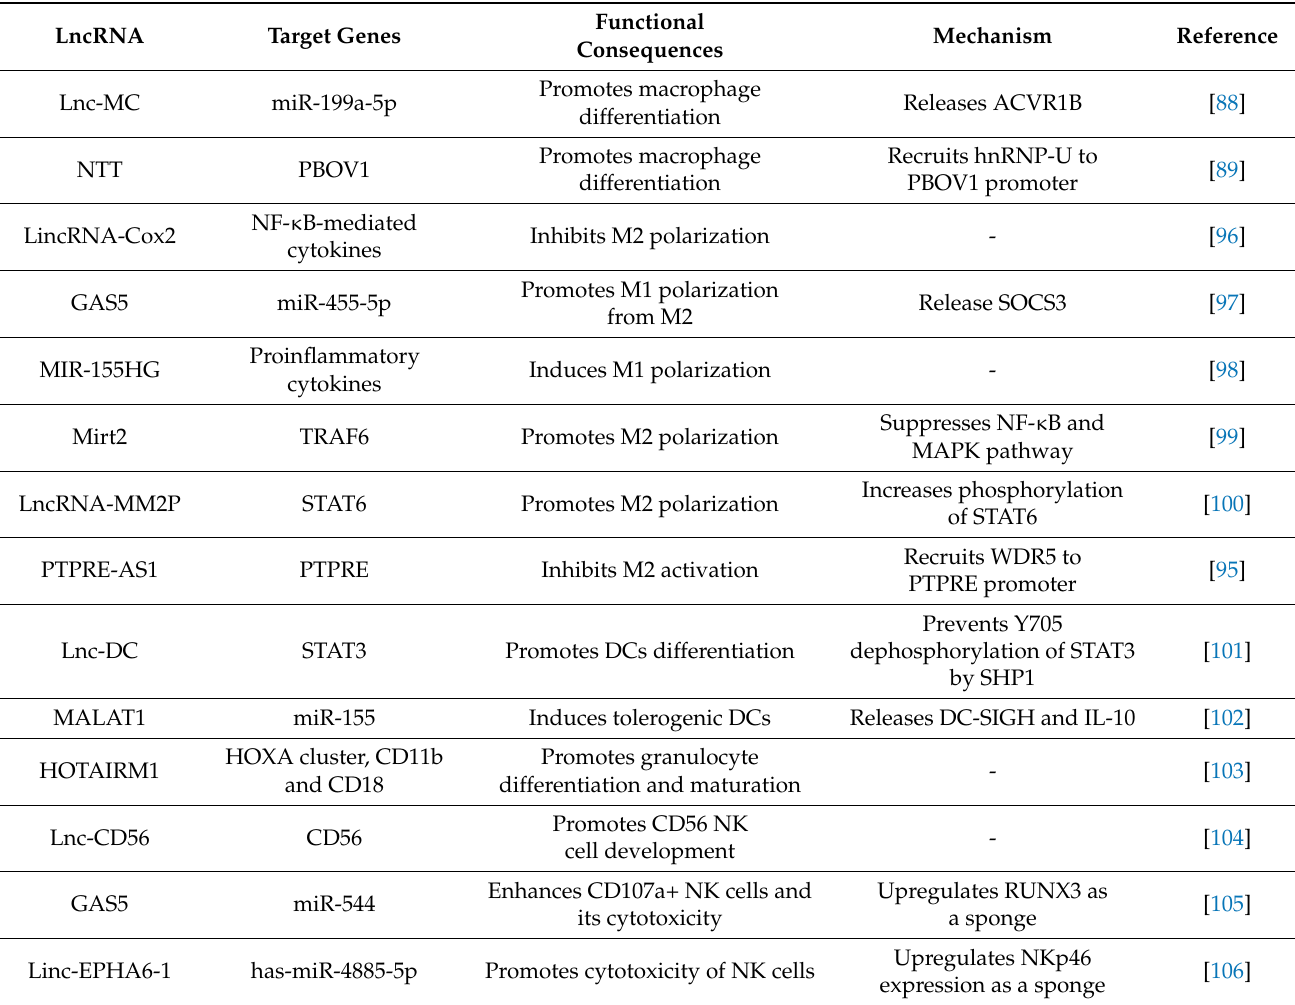
Table 1. Long non-coding RNAs in the development and polarization of innate immune